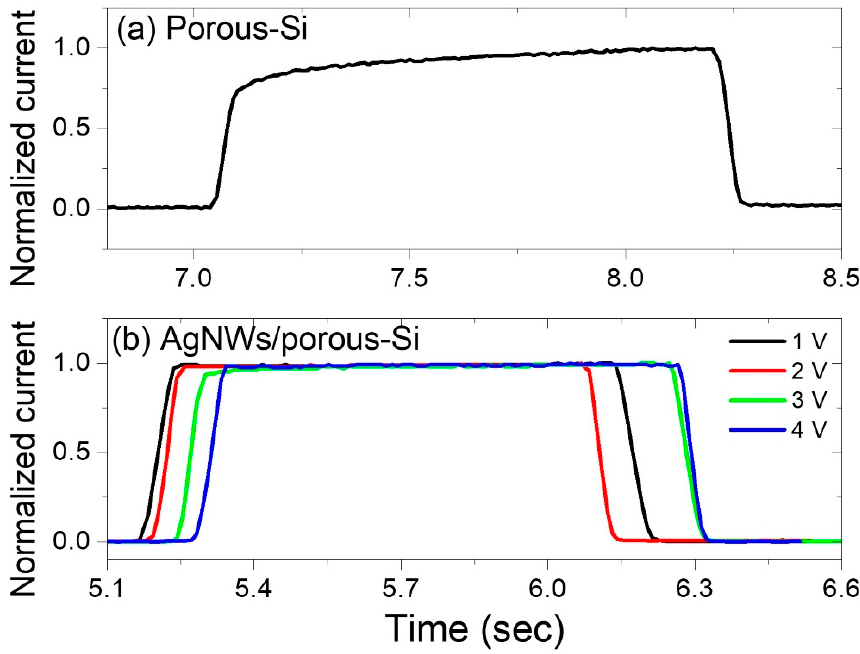
Figure 14. The normalized current versus time of ( a ) the P-Si and ( b ) the AgNWs/P-Si photodetector due to 385 nm and 395 nm wavelengths at a 1 V voltage.